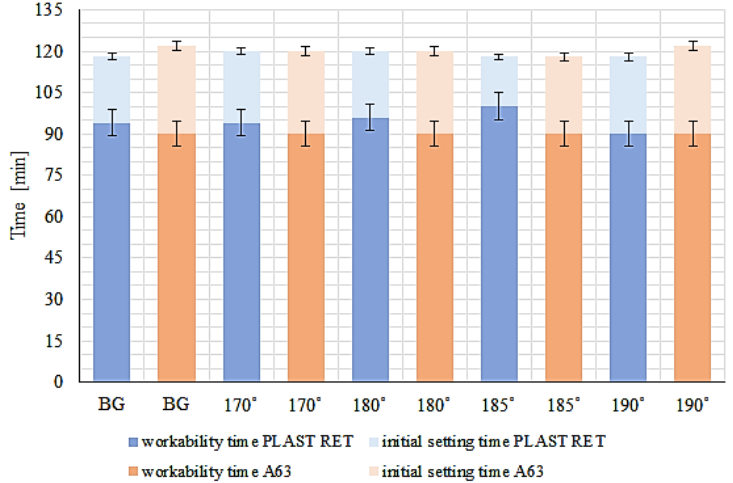
Figure 12. Relationships between the setting times and workability of plastering mortars modified with tartaric acid and Plast Ret as a function of the synthetic gypsum calcination temperature, which was calculated with an error bar value of 5%.